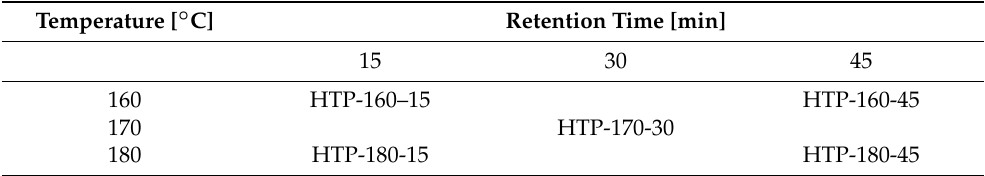
Table 1. Pretreatment conditions for hydrothermal wheat straw disintegration based on 2 k -factorial design. Temperature [ ◦